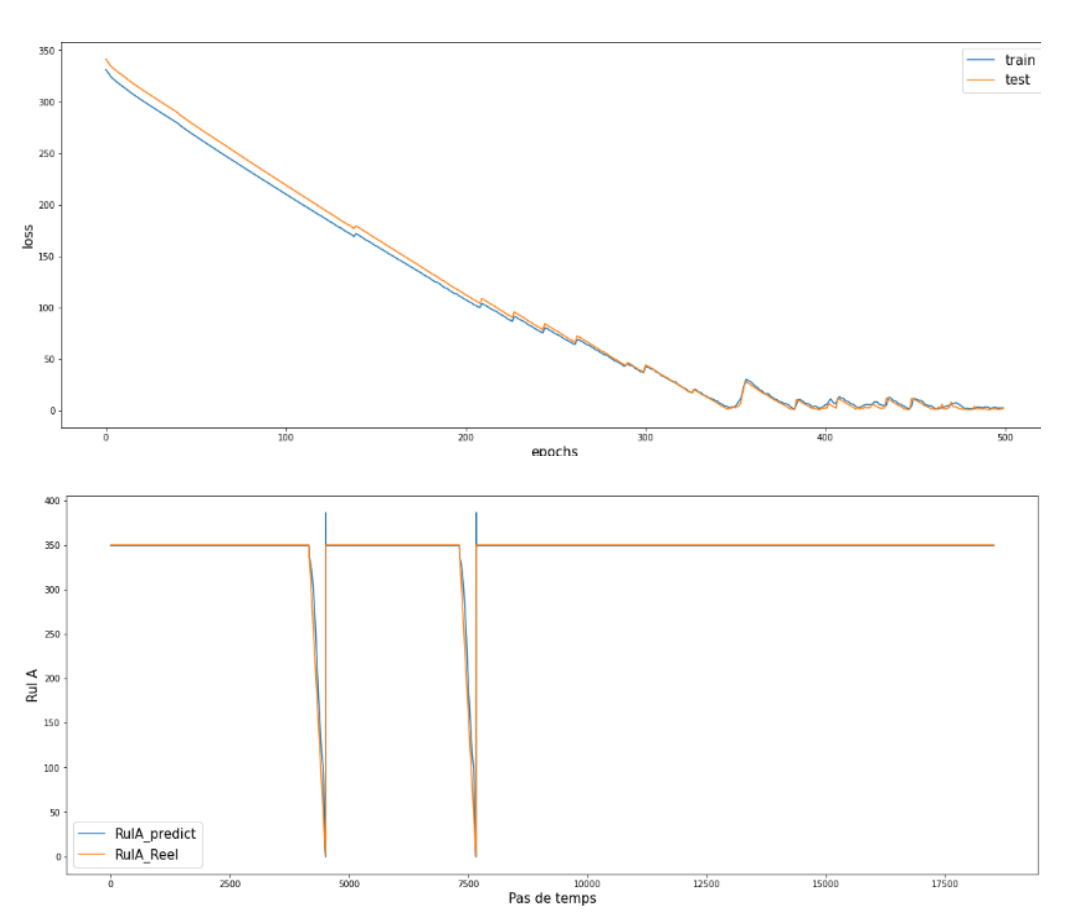
Figure 15. LSTM method for cluster 1 continuous-RULA . Mean squared error = 147.2550818147693. Cluster 2: